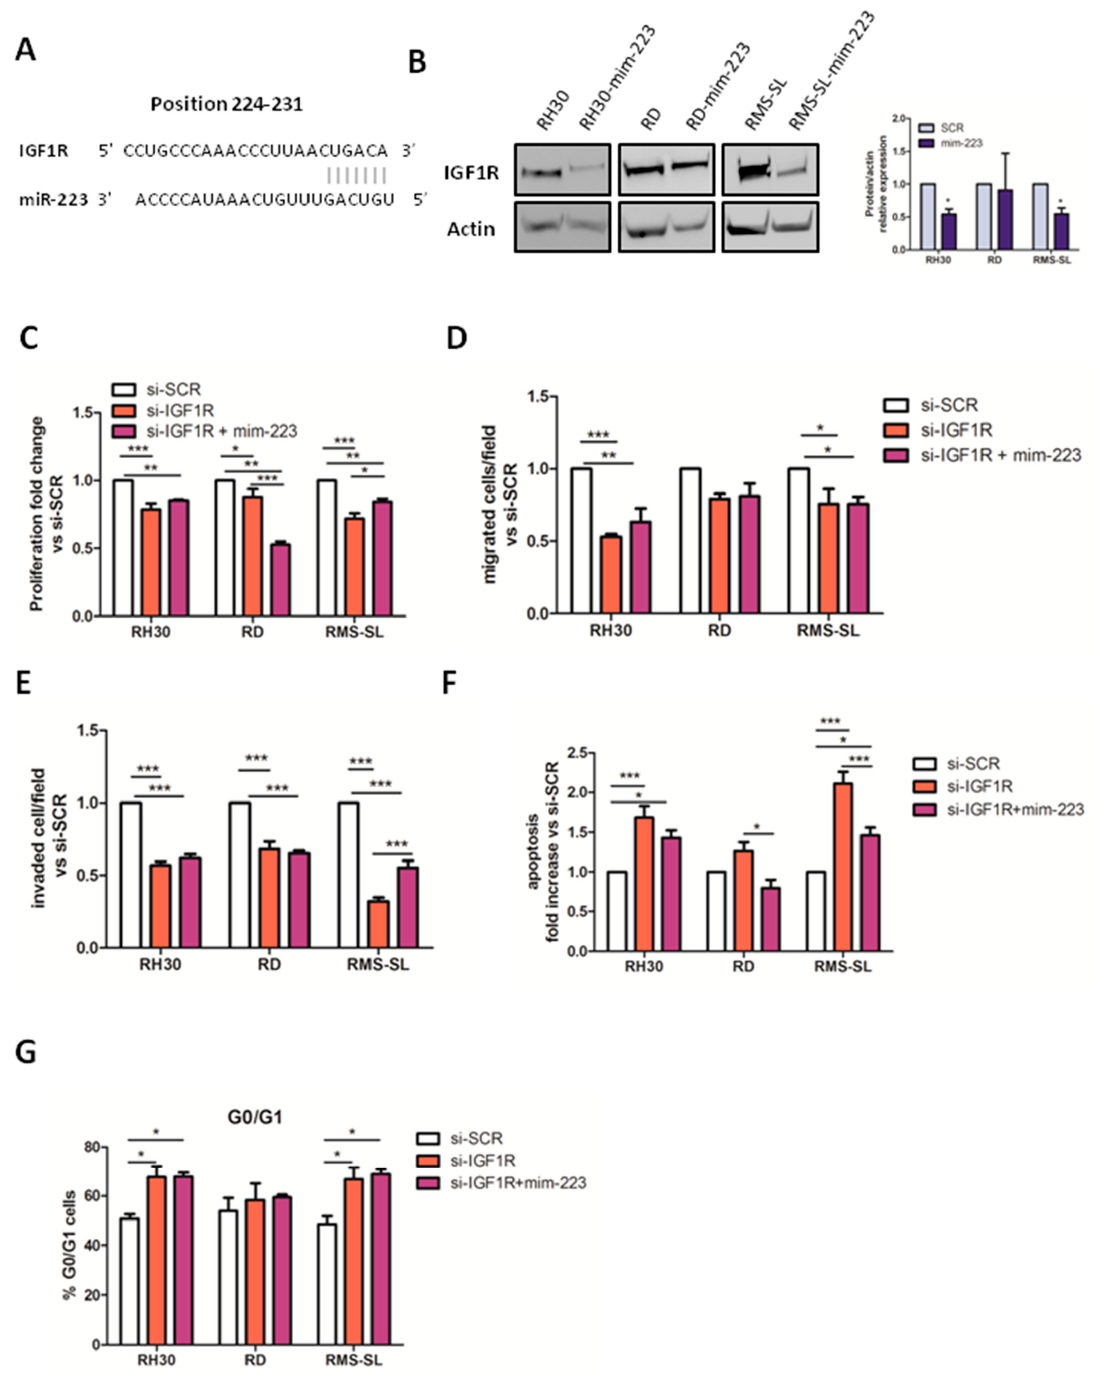
Figure 3. IGF1R is a direct target of miR-223. ( A ) Predicted IGF1R 3 (cid:48) UTR-binding site for miR-223. The figures show alignment of the miR-223 seed sequence with IGF-1R 3 (cid:48) UTR. ( B ) Results of IGF1R analysis by Western blot ( n = 3) and representative Western blot bands. ( C ) Proliferation of RMS cell lines trasfected with siRNA of IGF1R with or without addition of miR-223 mimics compared to controls ( n = 4). IGF1R silencing and miR-223 replacement inhibited the migratory ( D ) and invasive ( E ) of RMS cells ( n = 3 for each cell lines). ( F ) Apoptosis was measured by flow cytometry as annexin V + cells compared to cell transfected with si-SCR control ( n = 5 for each cell lines) ( G ) Percentage of RMS cells transfected with si-IGF1R and si-IGF1R + mim-223 in G0/G1 cell cycle’s phase ( n = 5 for each cell lines). All data are expressed as mean ± SEM. * p < 0.05, ** p < 0.01, *** p < 0.001 vs. cells transfected with si-SCR